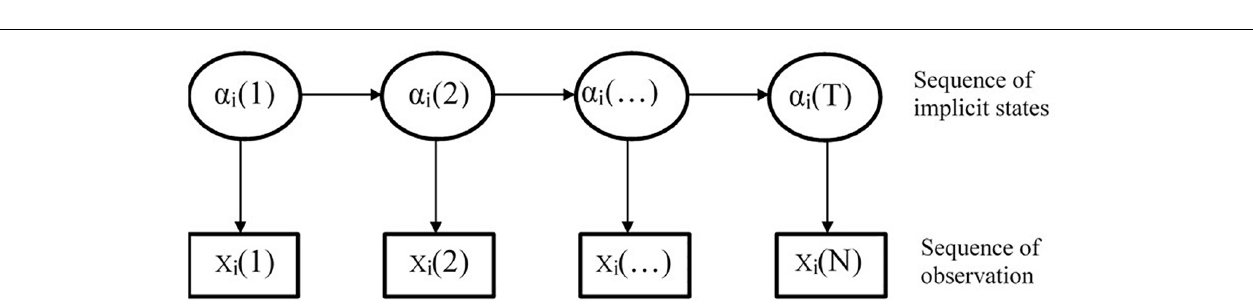
FIGURE 2 | Hidden Markov